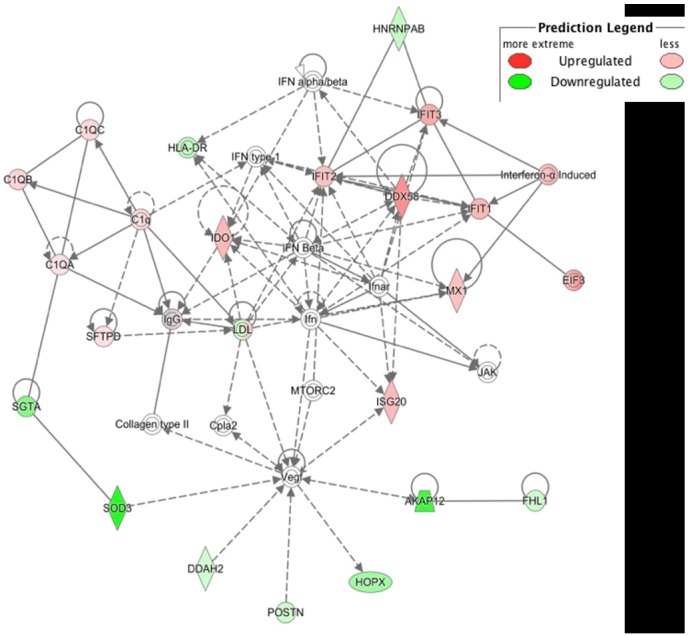
Network pathway analysis of proteins identified in the BAL fluids of samples from i.a. challenged NHP 7 days post-infection, compared to samples from i.a. challenged NHP 5 days post-infection.The network highlights proteins involved in immune response. Proteins in green highlight a 2-fold or more decrease in abundance in the NHP 7 days post-infection compared to samples from NHP 5 days post-infection. Proteins in red highlight a 2-fold or more increase in abundance. The shapes separate the different molecular classes. The solid lines represent a direct molecular interaction and the dashed lines an indirect molecular interaction.